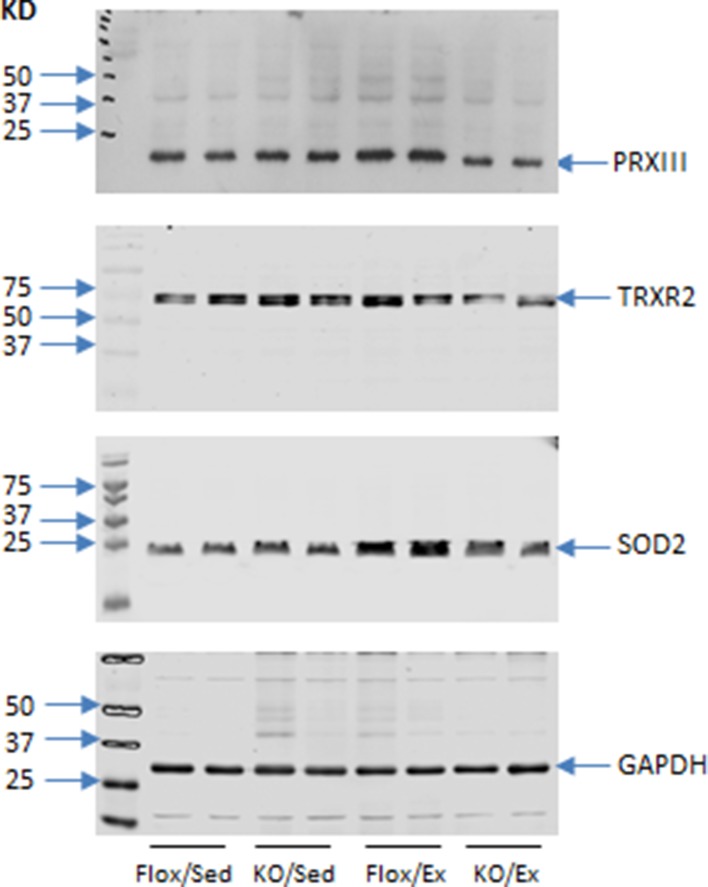
Full images of Western blots in Figure 4.